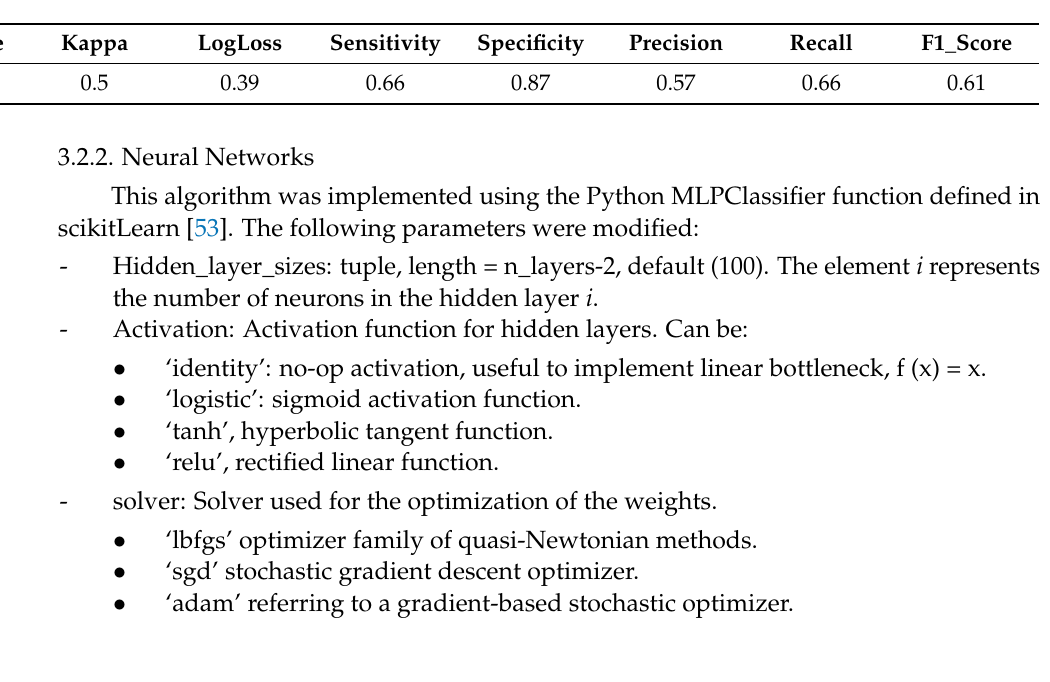
Table 9. Metrics evaluated for Random